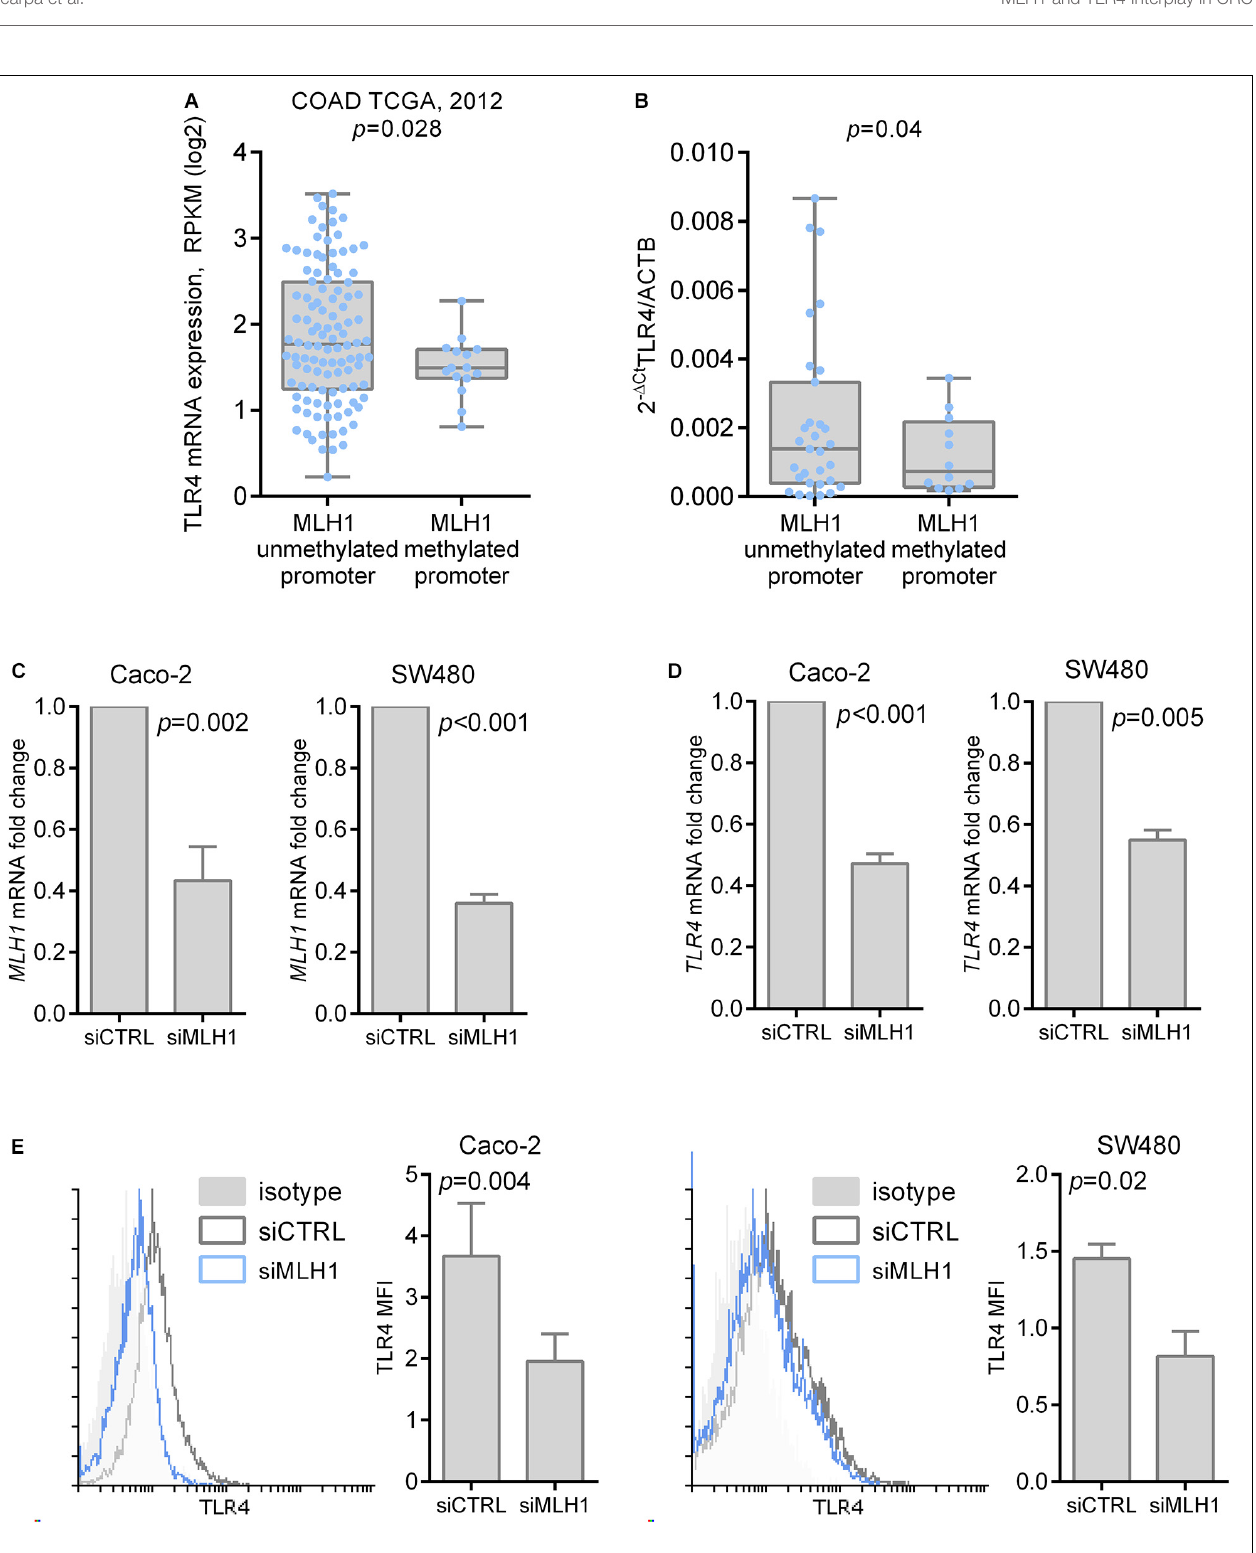
FIGURE 4 | TLR4 expression is influenced by MLH1 deficiency. (A) TLR4 mRNA expression according to epigenetic silencing of MLH1 in tumor samples of COAD TCGA dataset. (B) TLR4 mRNA expression according to epigenetic silencing of MLH1 in the healthy colon mucosa of 63 patients. (C) Efficiency of MLH1 specific silencing in Caco-2 and SW480 cells quantified by qRT-PCR. (D) TLR4 mRNA expression quantification in Caco-2 and SW480 cells transfected with specific MLH1 siRNA or control siRNA. (E) Cell surface expression of TLR4 in Caco-2 and SW480 cells transfected with specific MLH1 siRNA or control siRNA was measured by flow